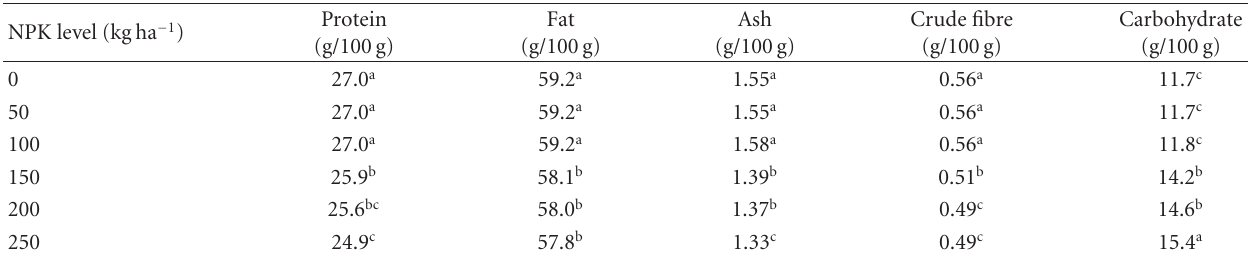
Table 3: Proximate composition of Pumpkin seeds as a ff ected by NPK fertilizer levels.